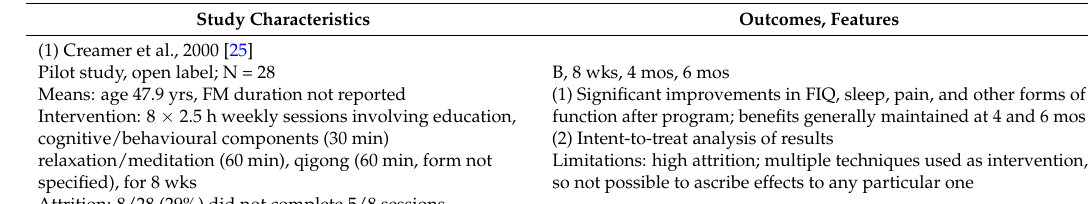
Table 3. Summary of other studies of qigong for